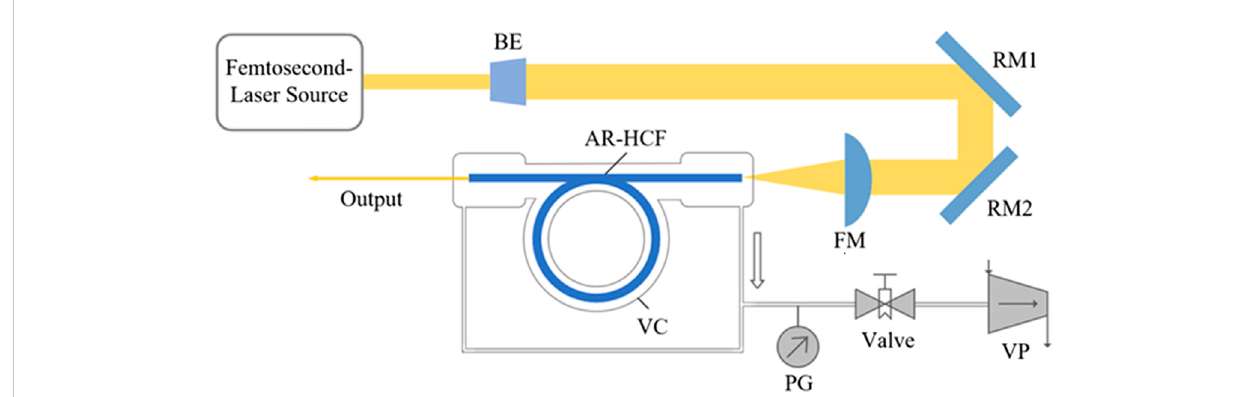
Experiment setup of the laser beam transmission system. BE: Beam expander; RM: Re fl ect mirror; FM: Focus mirror; VC: Vacuum chamber; PG: Pressure gauge; VP: Vacuum pump.